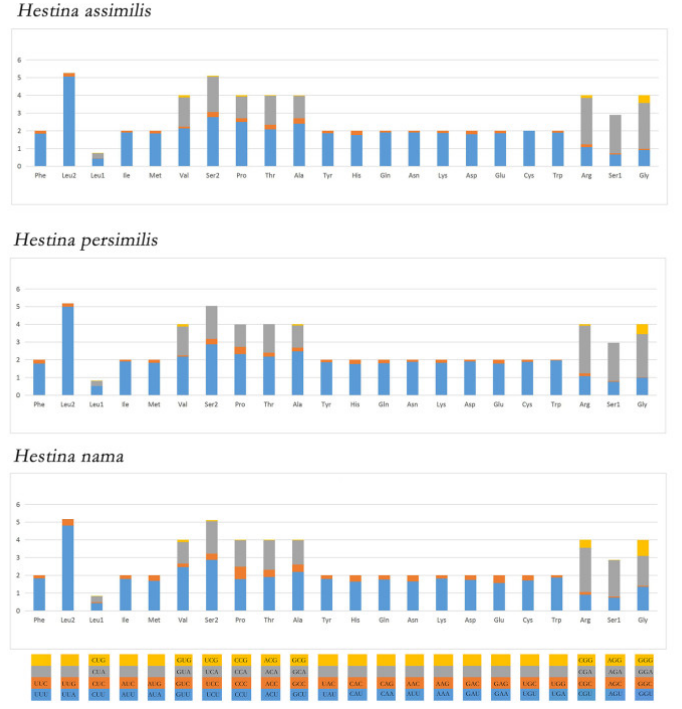
Figure 3. Relative Synonymous Codon Usage (RSCU) in the mitogenomes of twelve Apaturinae species. Codon families are provided on the X axis.